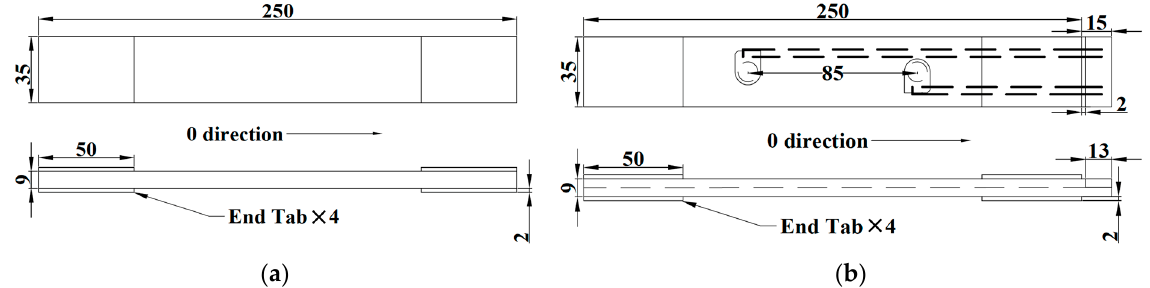
Figure 1. Schematic of drawings for ( a ) normal coupons and ( b ) coupons with embedded PZT transducers (unit: mm).